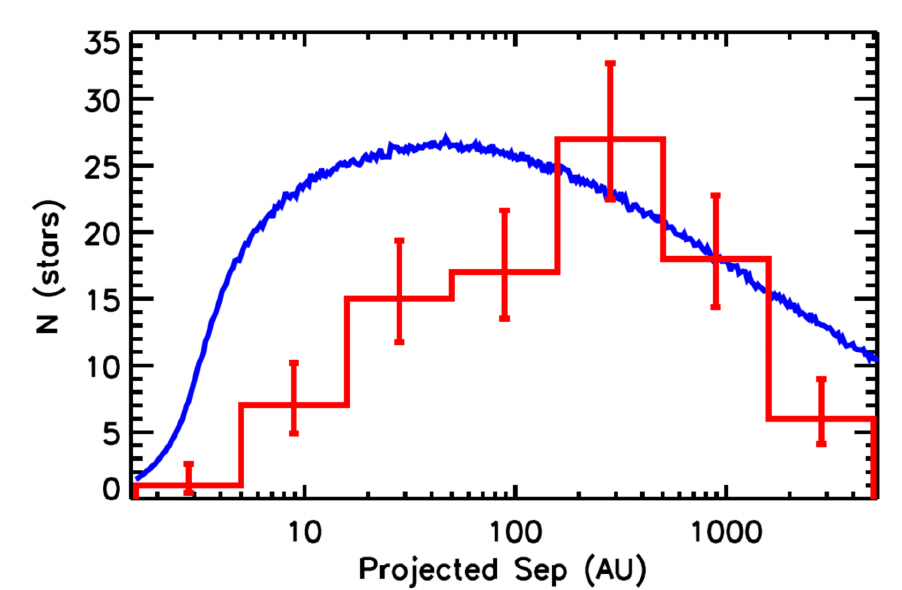
Figure 2. Red histogram: Marginalized distribution N ( ρ ) of projected separations for all stellar companions to S-type exoplanet-host stars found by [18] for a large sample of Kepler Objects of Interest (KOIs). The blue line represents the predicted distribution if binaries were drawn from the distribution reported by [2]. Taken from [18], courtesy of the Astrophysical